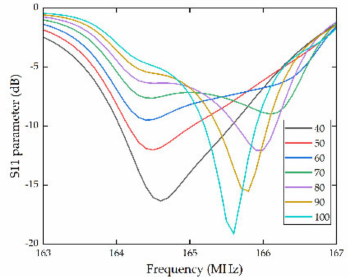
Figure 6. S11 curves of SAW sensors with seven kinds of reflecting grid logarithms.